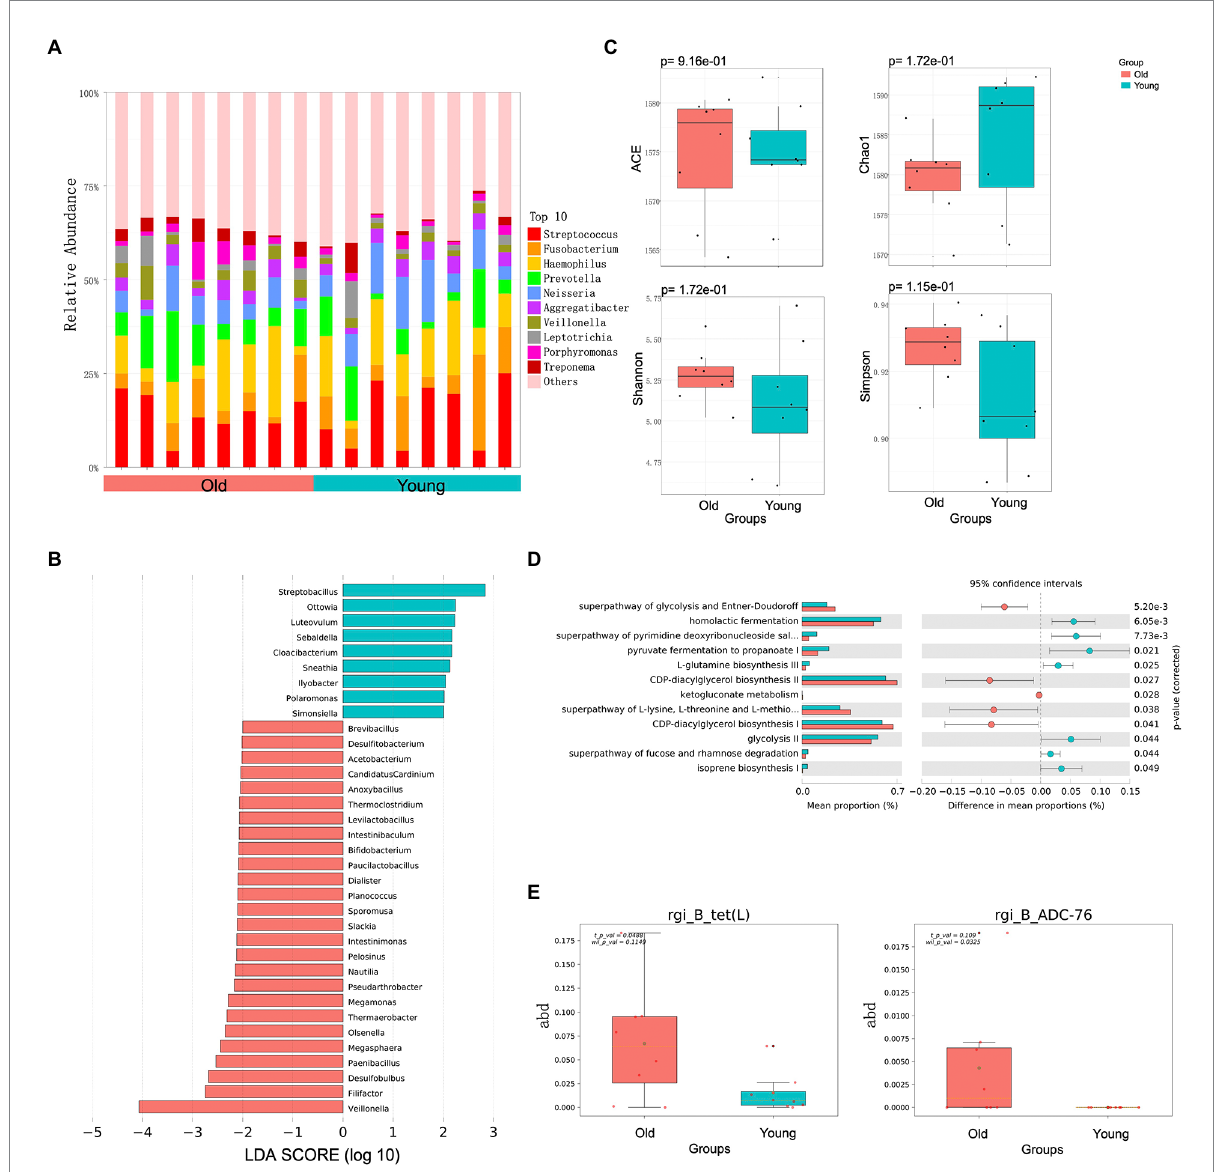
FIGURE 2 Metagenomics analysis of oral microbiota. (A) Top 10 most abundant genera in oral microbiome between young and old groups. (B) Differential analysis of oral microbial composition in young and old groups. (C) Alpha ( α ) diversity estimates between young and old groups. (D) Differential analysis of oral microbial function in young and old groups. (E) Differential analysis of oral microbial ARGs in young and old groups. p < 0.05 was considered